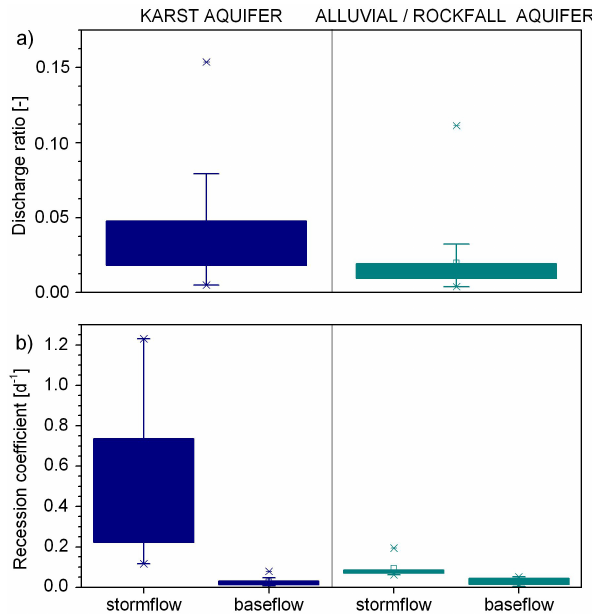
Figure 11. Discharge ratios (a) and recession coefficients (b) of the karst aquifer and the alluvial/rockfall aquifer in the